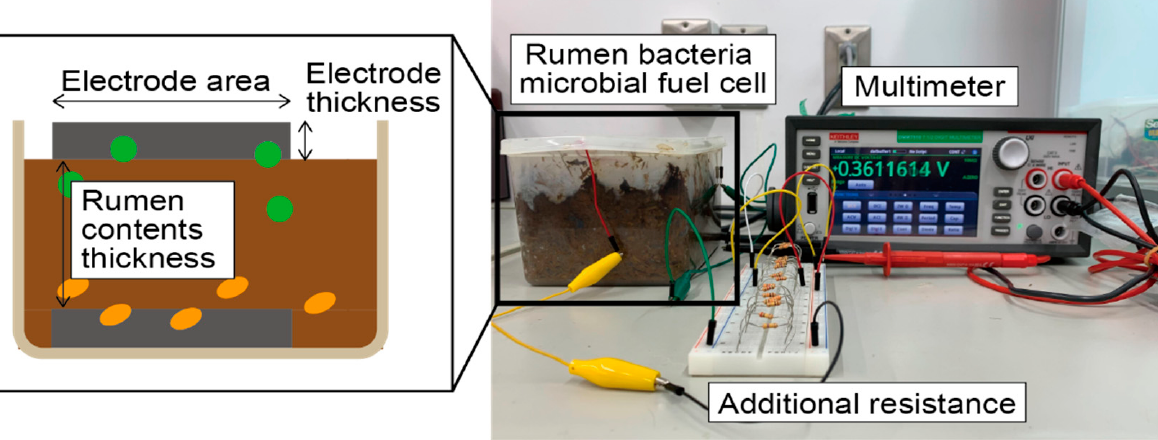
Figure 2. Image of the measurement setup. The relationship between each parameter is also shown.